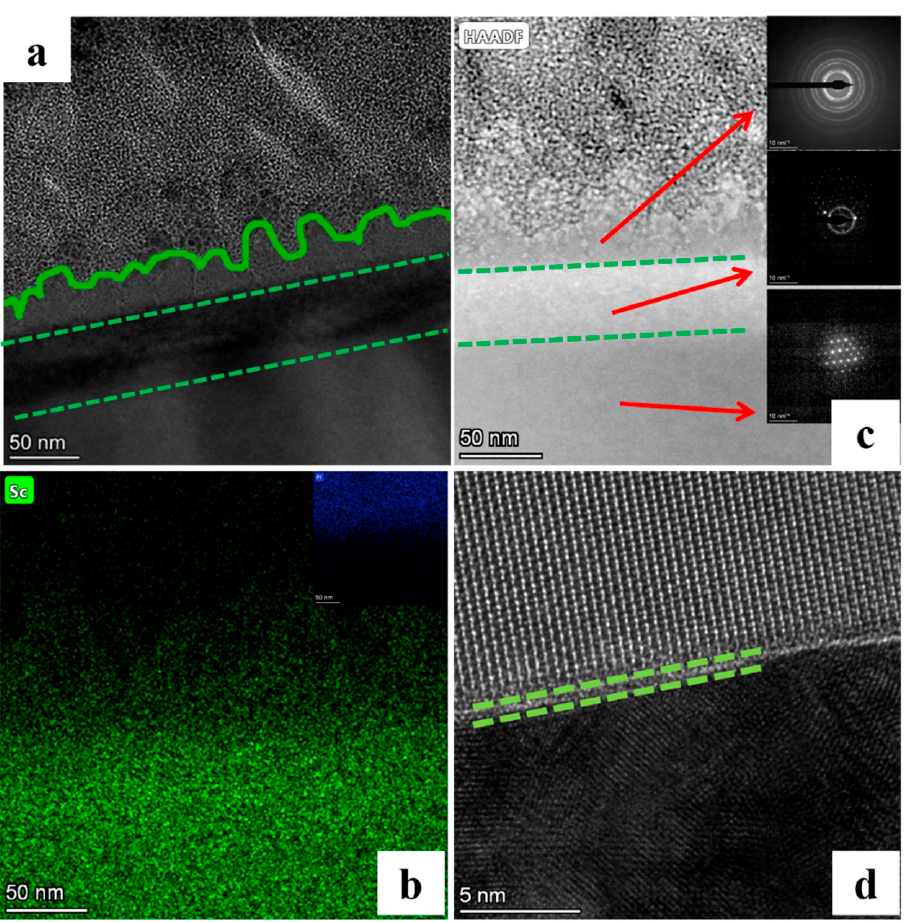
Figure 16. High-resolution transmission electron microscopy of surface defects/matrix micro region ( a ) TEM, ( b ) HAADF image with electron diffraction pattern of three regions, ( c ) EDS map, and ( d ) HRTEM.